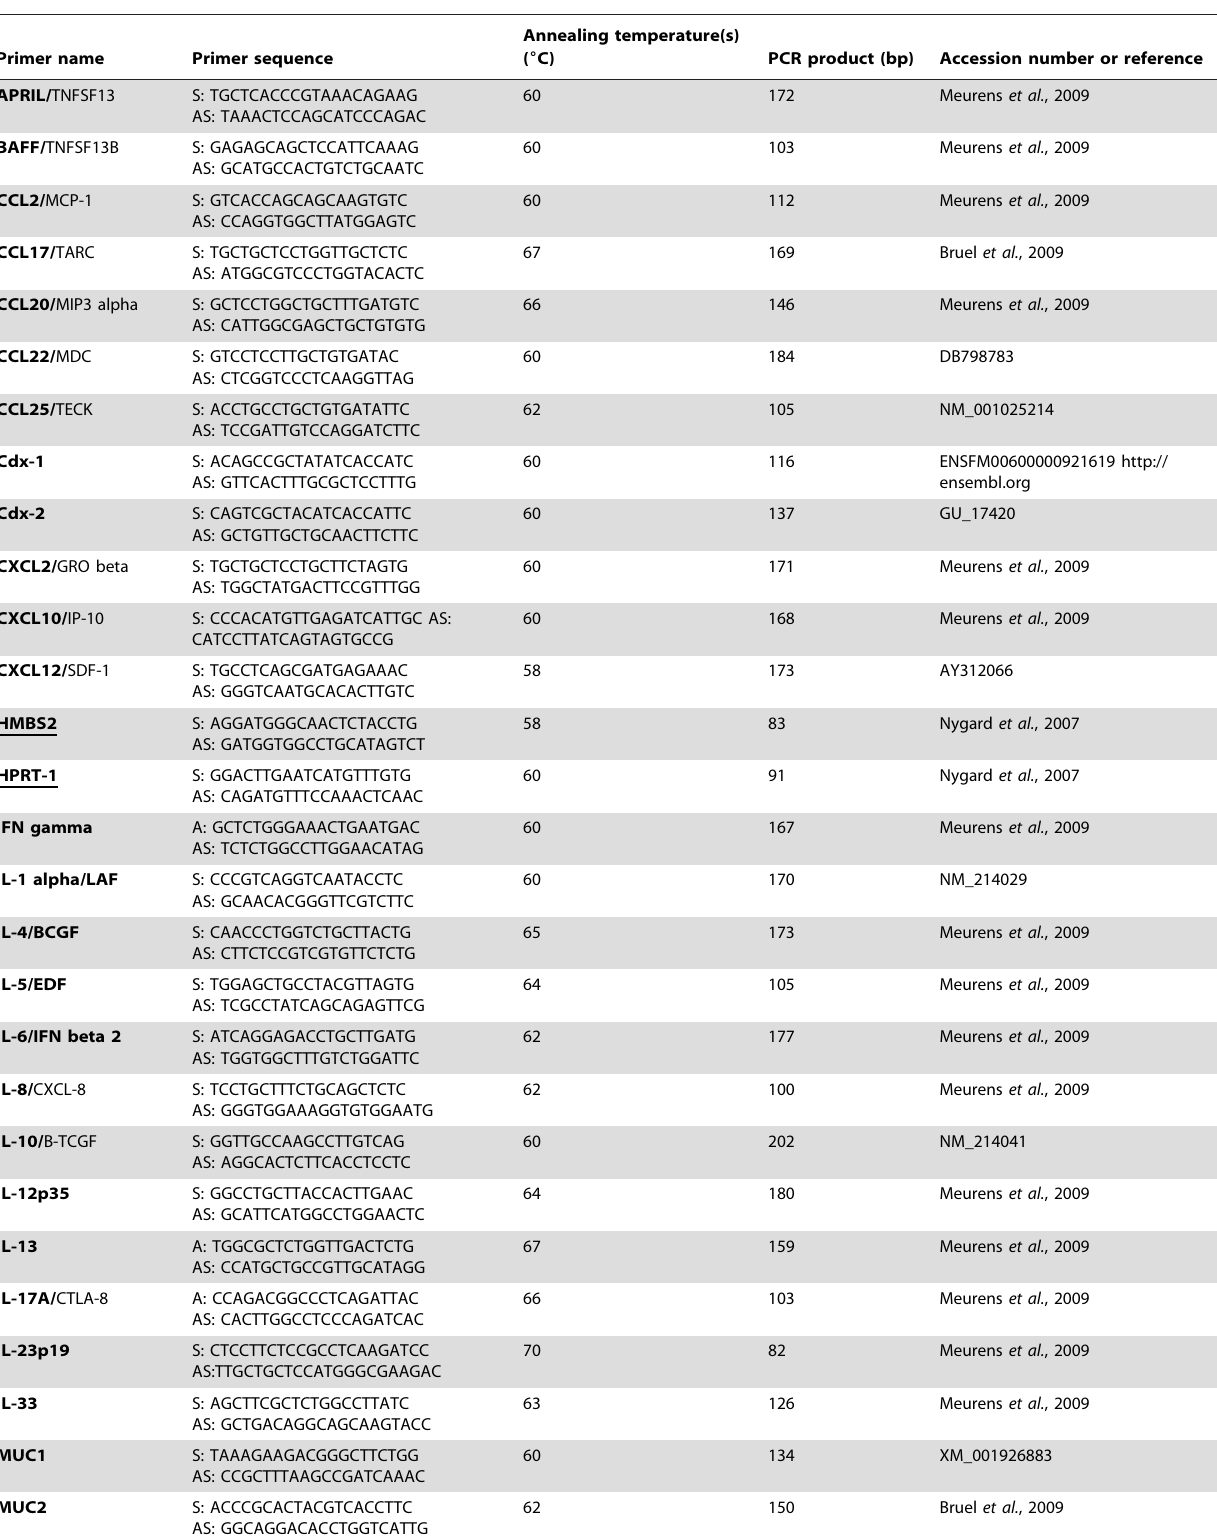
Table 1. Primer sequences, annealing temperatures of primer sets ( u C), expected PCR fragment sizes (bp) and accession numbers or